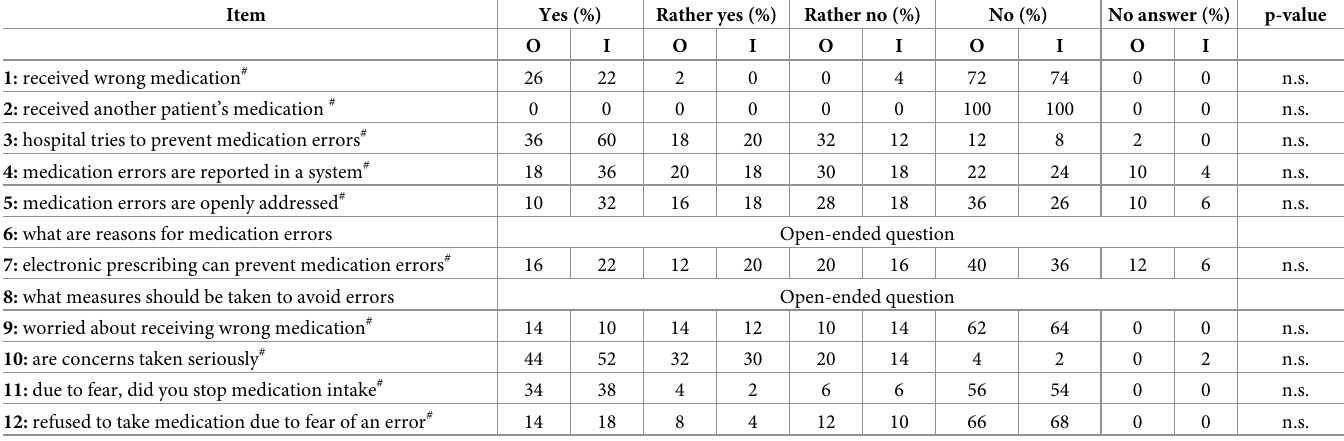
Table 2. Beliefes on medication errors (group I = insulin; group O = oral antihyperglycaemic agent). Differences were calculated between both groups (O/I), duration of diabetes (D), age (A), gender (G) and education level (E). Any significance is given in the column “p-value” (n.s. = not significant). Significant differences for duration of diabetes, age, gender and education level are indicated in the description below the table.